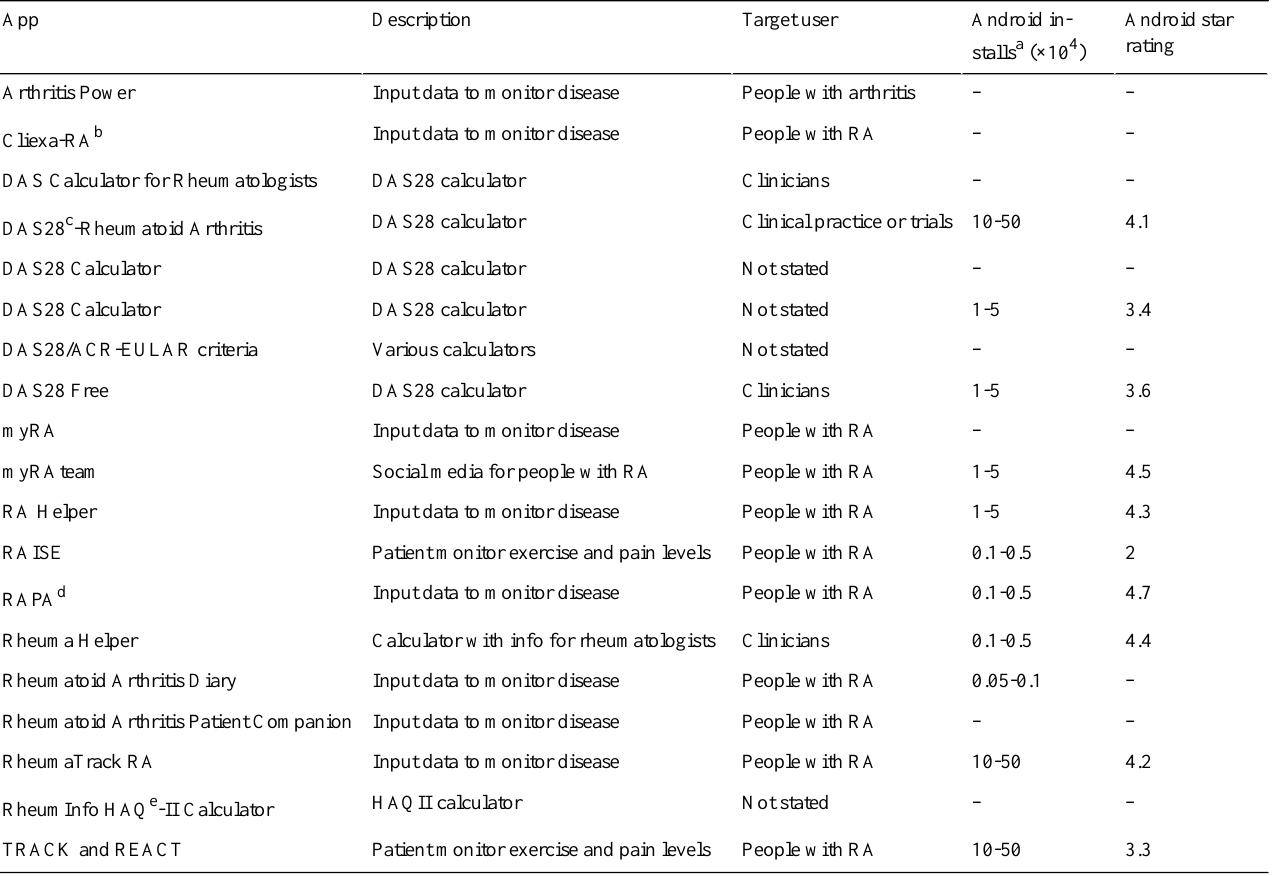
Table 3. Description, target user, Android installs, and star rating of included apps.